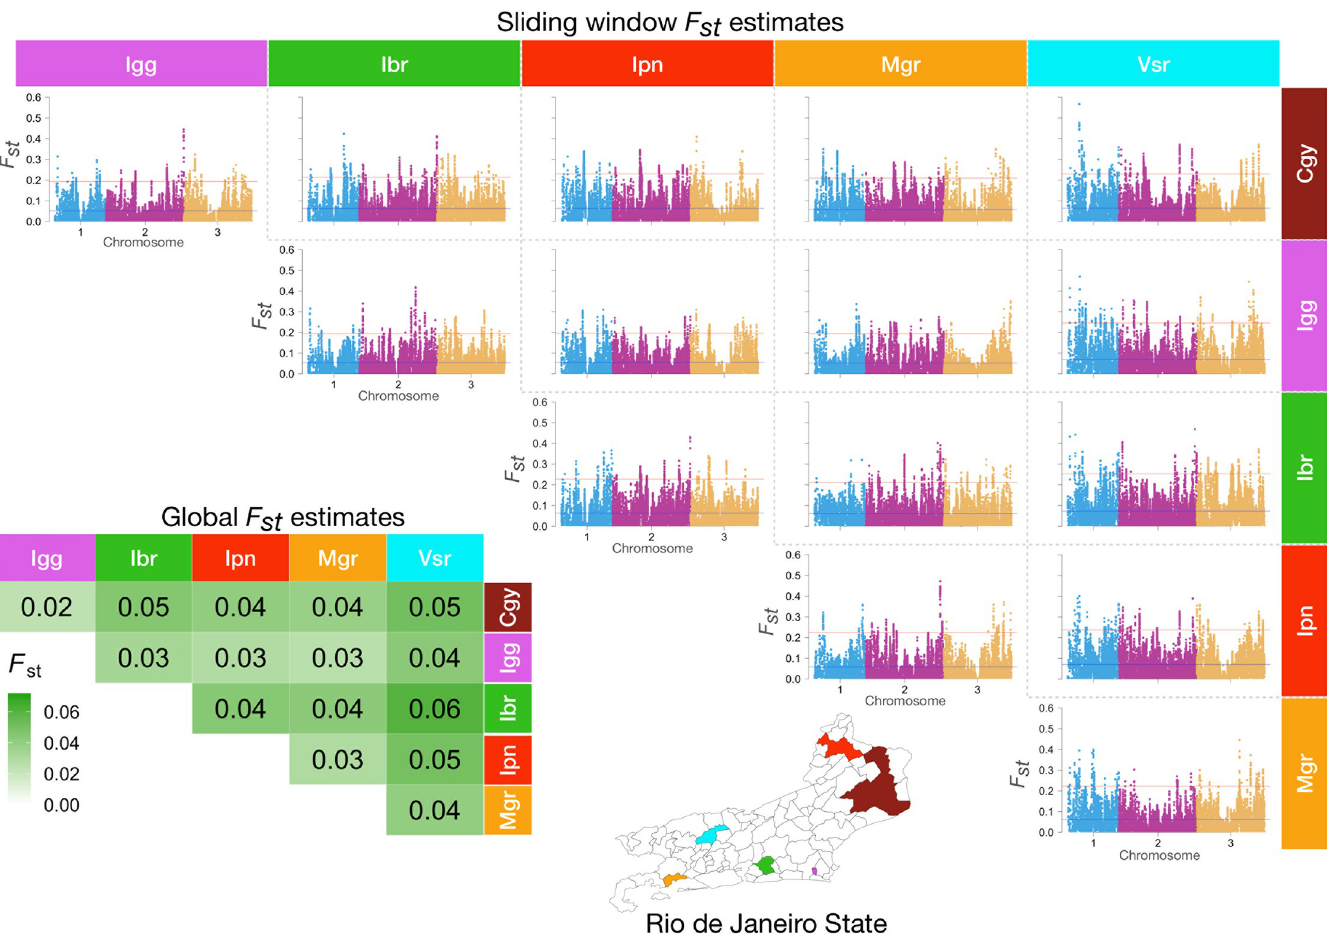
Fig 9. Global estimates of genetic differentiation ( F ) among populations of Aedes aegypti in Rio de Janeiro (lower left) and sliding window estimates across the st genome (upper right).